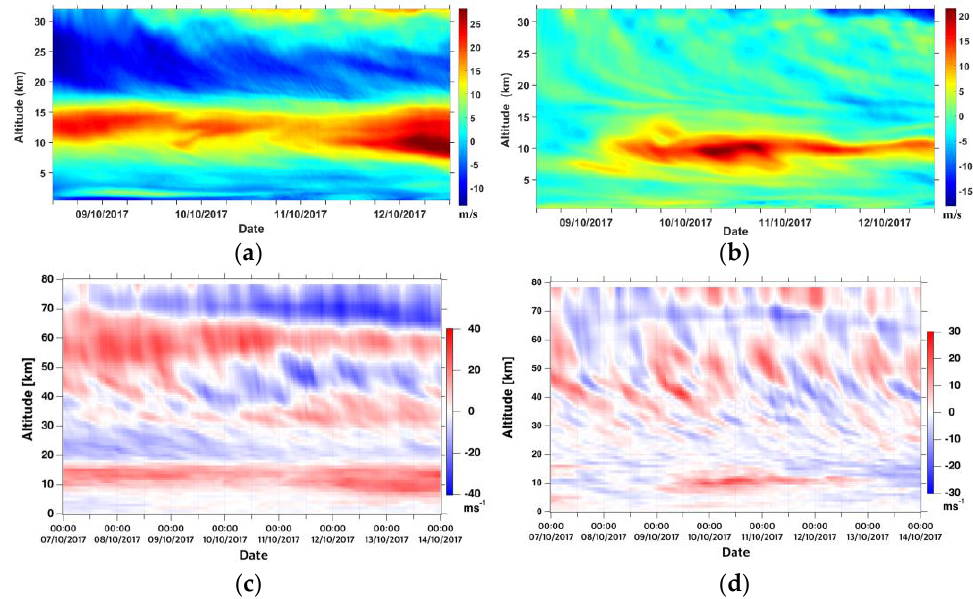
Figure 15. Time–height distribution of zonal ( left ) and meridional wind ( right ) expressed in m/s above La Réunion derived from ( a , b ) WRF 6 min outputs and ( c , d ) hourly ERA5 dataset.